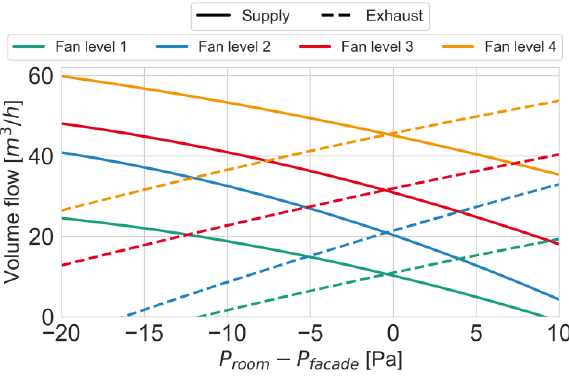
Figure 10. Supply and exhaust airflows given the air speed and pressure difference.